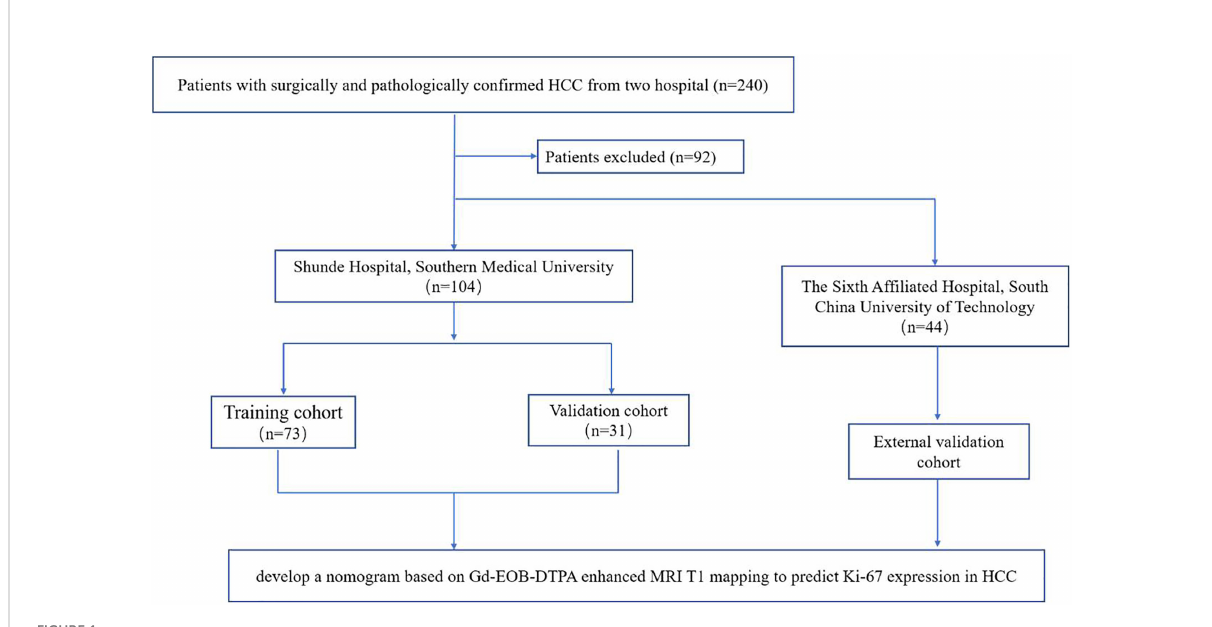
FIGURE 1 Flowchart of patient selection in the